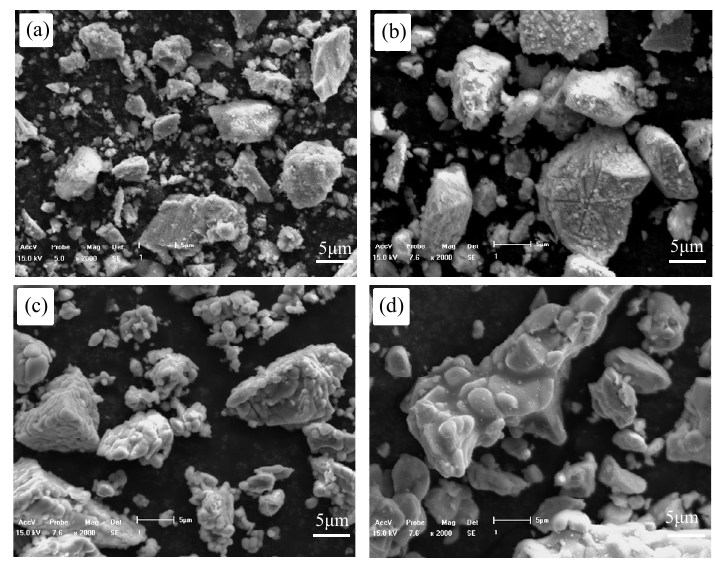
Figure 8. Changes of concentrate appearances at different roasting temperatures: ( a ) Raw material; ( b ) Sample after roasting at 800 ◦ C; ( c ) Sample after roasting at 1000 ◦ C; ( d ) Sample after roasting at 1200 ◦ C.